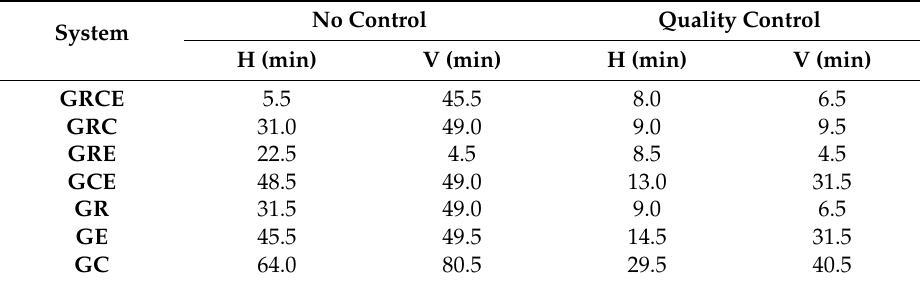
Table 3. The convergence time statistic in horizontal (H) and vertical (V) components.